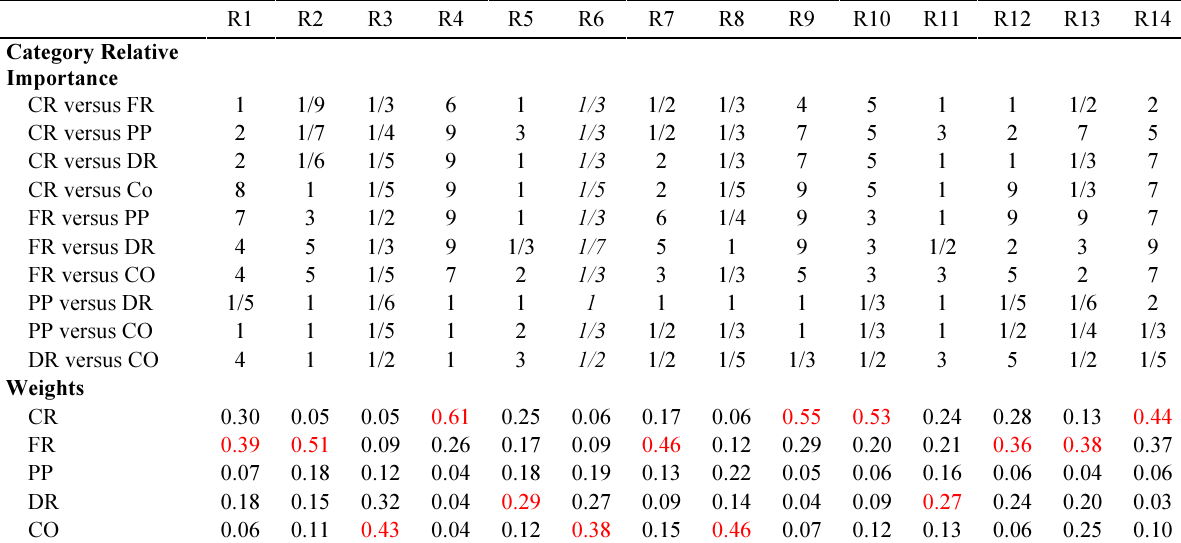
Table 1. Category pairwise comparison matrix and relative weights R1 R2 R3 R4 Category Relative Importance